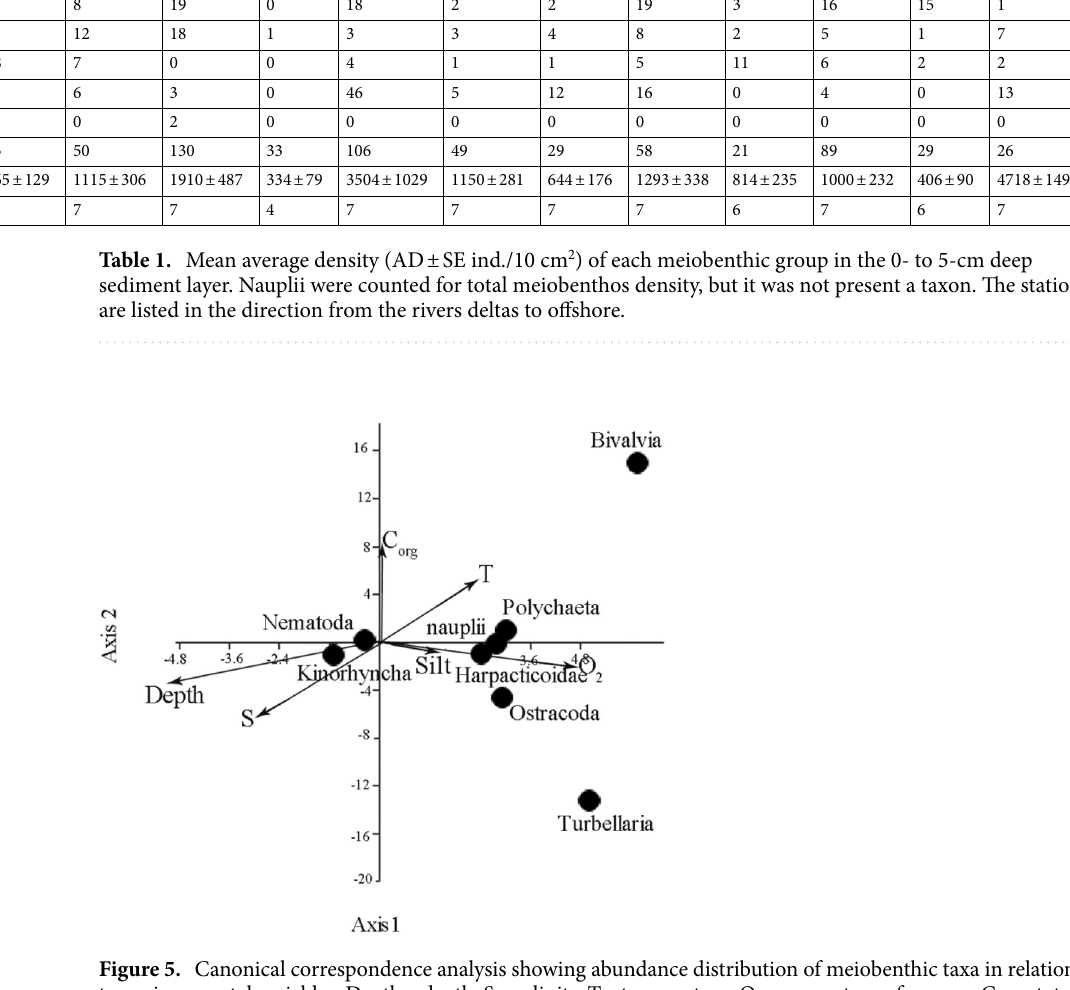
Figure 5. Canonical correspondence analysis showing abundance distribution of meiobenthic taxa in relation to environmental variables: Depth—depth, S—salinity, T—temperature, O 2 —percentage of oxygen, C org —total C org, Silt—silt